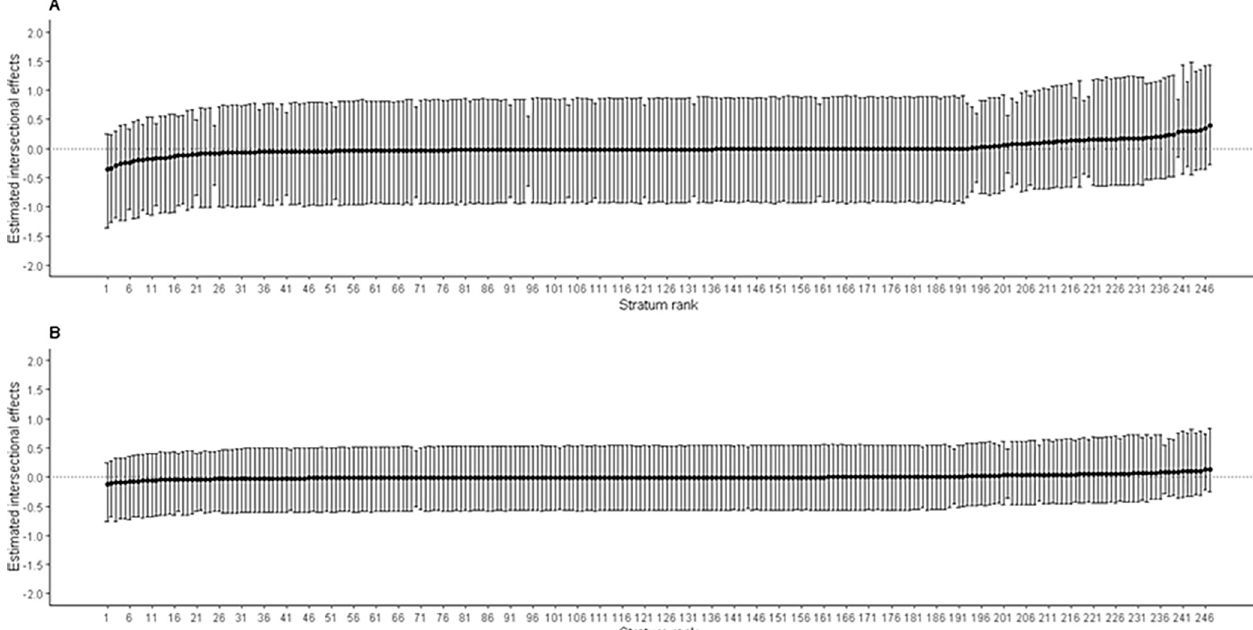
Fig 4. Estimated intersectional effects (stratum-level residuals) and their corresponding 95% credible intervals (CIs) for each stratum ranked from lowest to highest for acute respiratory infections (ARI). Panel A: An intercept model with only intersectional strata; Panel B: A full model after adding main effects (variables used to create intersectional strata) with intercept model. Negative values indicate lower risk (privileged groups) of ARI in under-five ‘than expected’ based on the additive contributions of the main effects, while positive values indicate higher risk (disadvantaged groups) of ARI in under-five ‘than expected’ for that